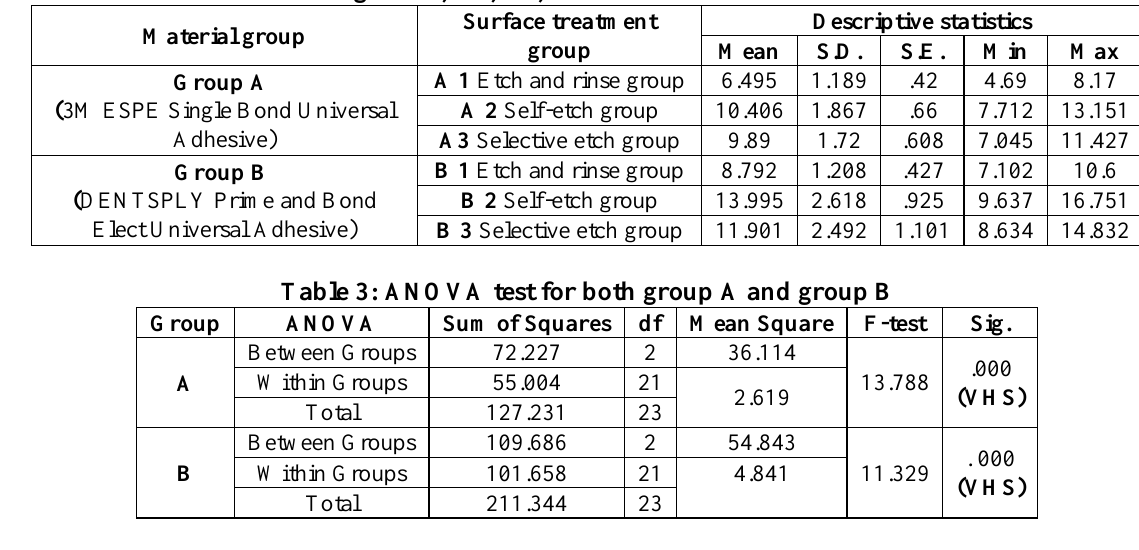
Table 4: LSD test between the subgroup of both group A and group B Groups